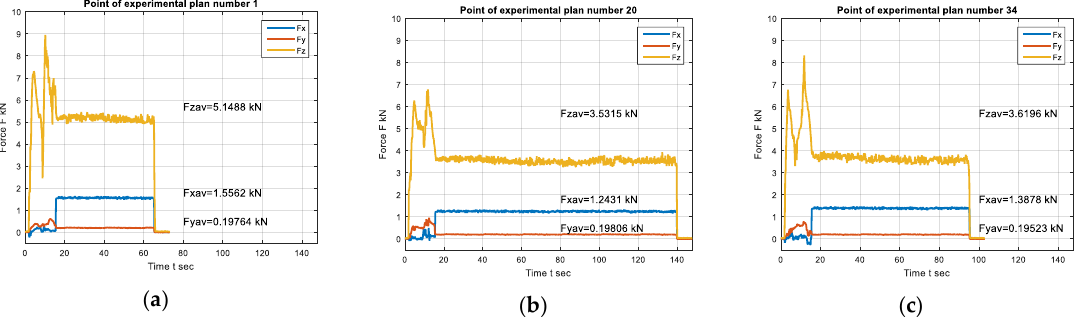
Figure 4. Diagram of forces F z , F x , and F y at the points of the experimental plan: ( a ) number 1; ( b ) number 20; ( c ) number 34.